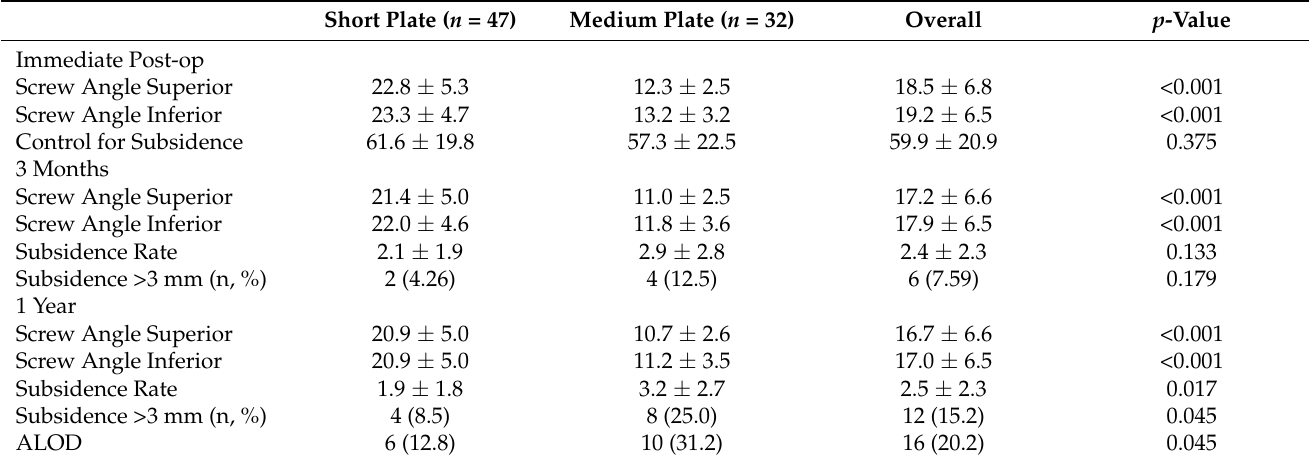
Table 2. Subsidence and presence of ALOD between short and medium plate.